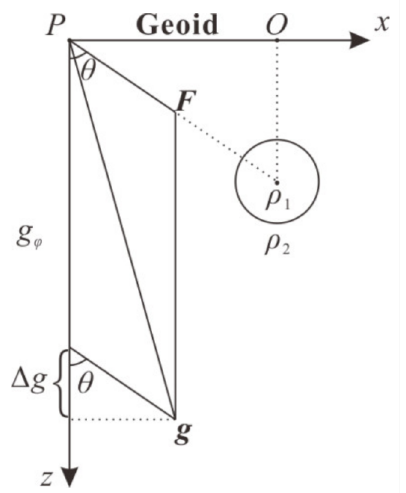
Figure A1. Physical significance of gravity